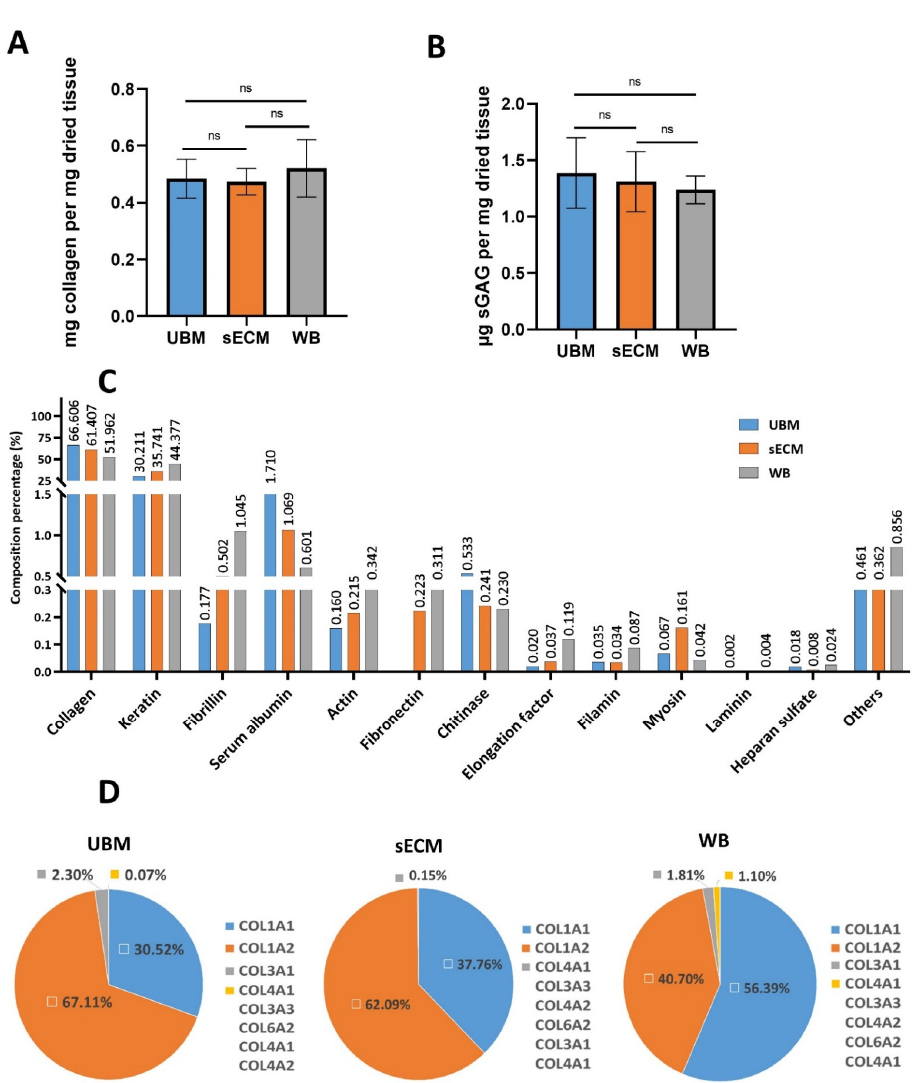
Figure 1. Biochemical composition. ( A ) Collagen content (mg/mg) ( n = 4). ( B ) sGAG content ( µ g/mg) ( n = 6). ( C ) Protein profiles of the decellularized tissues by LC-MC/MS. ( D ) Relative percentage of subdomains for collagen.